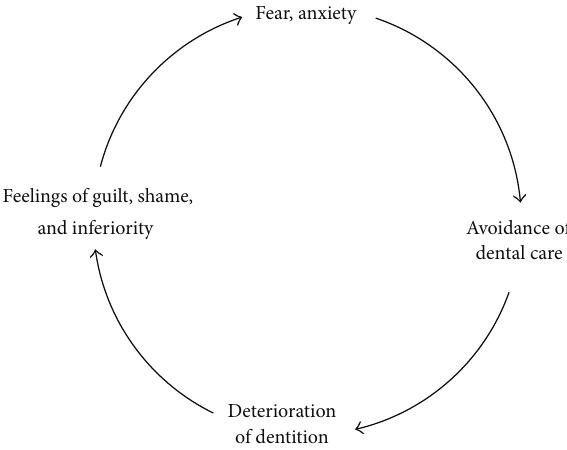
Figure 1: Vicious circle of dental anxiety [8,